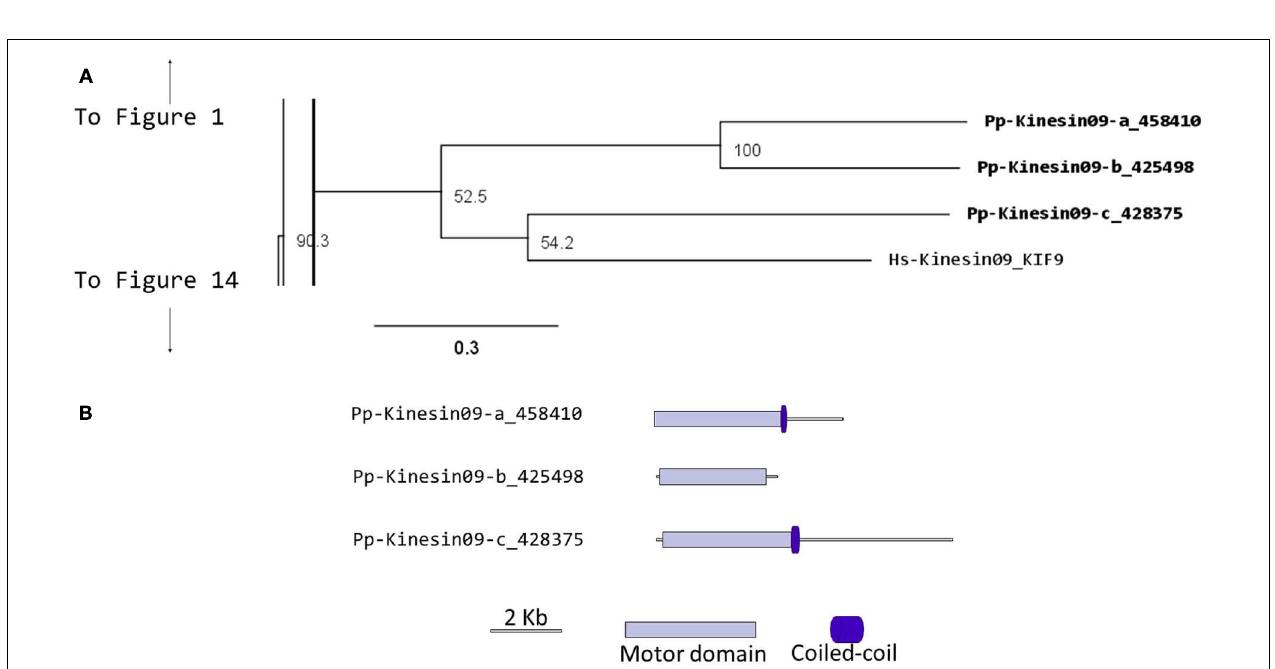
length corresponding to the number of substitutions per site.The Physcomitrella numbers correspond to the Phypa number uniquely associated with each gene model (version 1.6) at cosmoss.org. (B) Gene models of kinesin 9s. Schematic diagrams showing the structure and domain architecture of kinesin 9s. Domains are indicated at the bottom of the